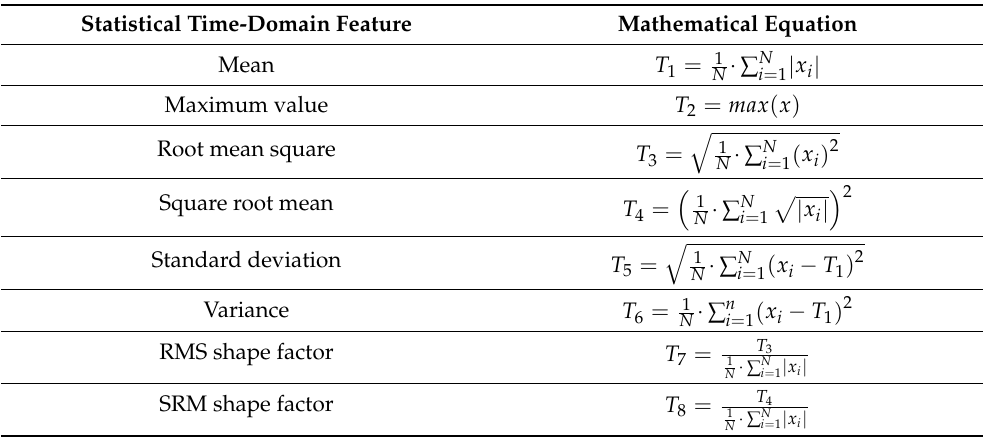
Table 2. Proposed set of statistical features for the characterization of the available signals during the processing in the time-domain analysis, where, x ( i ) is a sample for i = 1, 2, . . . , N , and N is the number of points for each acquired